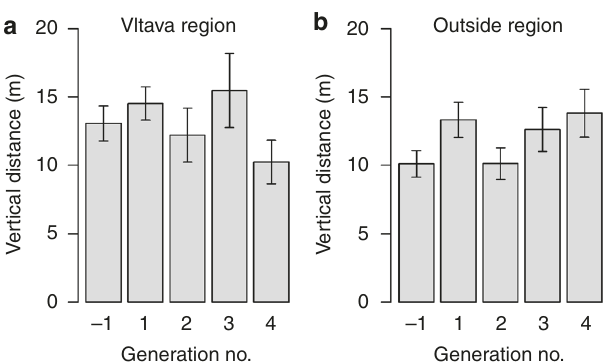
Fig. 2 Generations before and after the fl oods. Mean (±standard error) vertical distances of settlements above the water level of the nearest watercourse within a and outside b the Vltava region in fi ve consecutive generations (25-year periods): − 1: before the fl ood; 1 – 4: fi rst to